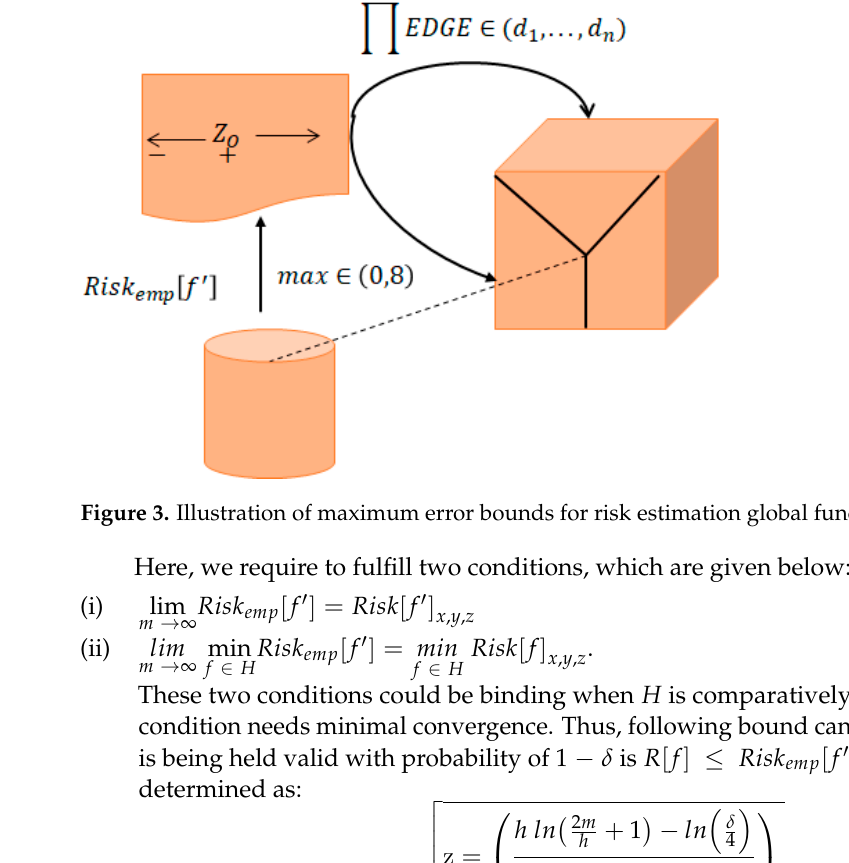
Figure 4. Illustration of risk estimation function in 3-d space for in-bound LE and GE. Algorithm 2 maximizes fitness, this algorithm computes the risk estimation function,